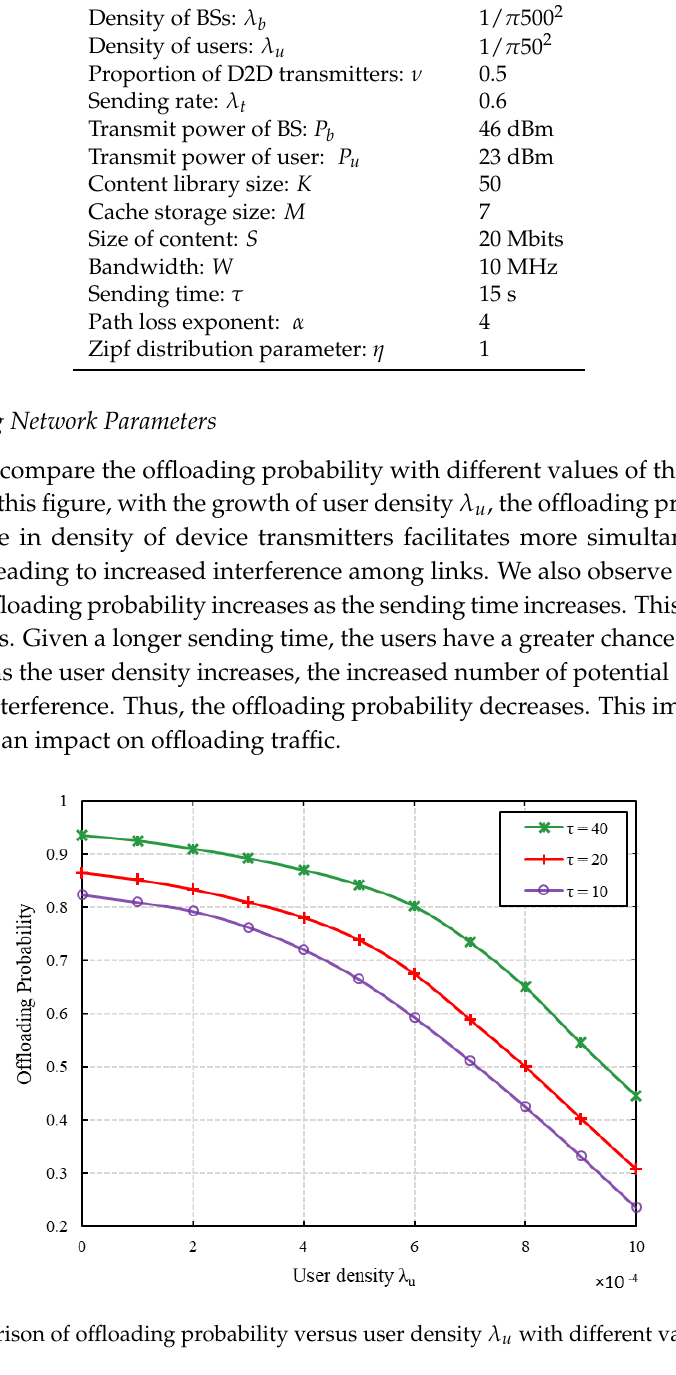
 with different values of u